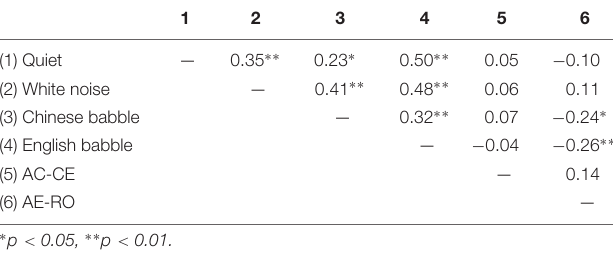
TABLE 3 | Correlations between participants’ performance in the four listening conditions and their learning mode preferences.